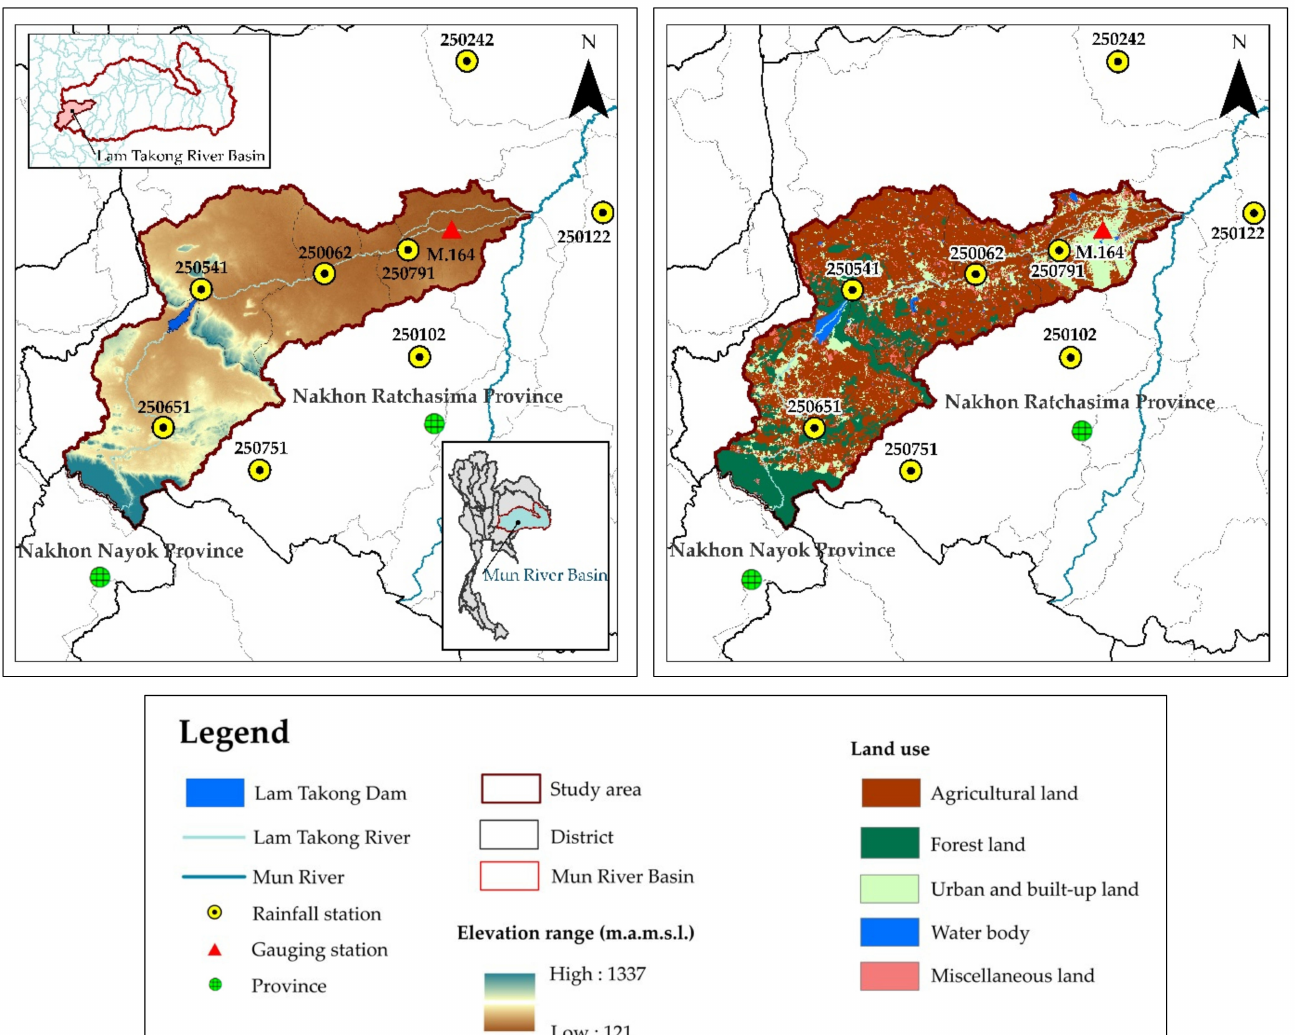
Figure 1. The Lam Takong River Basin, including its topography and land